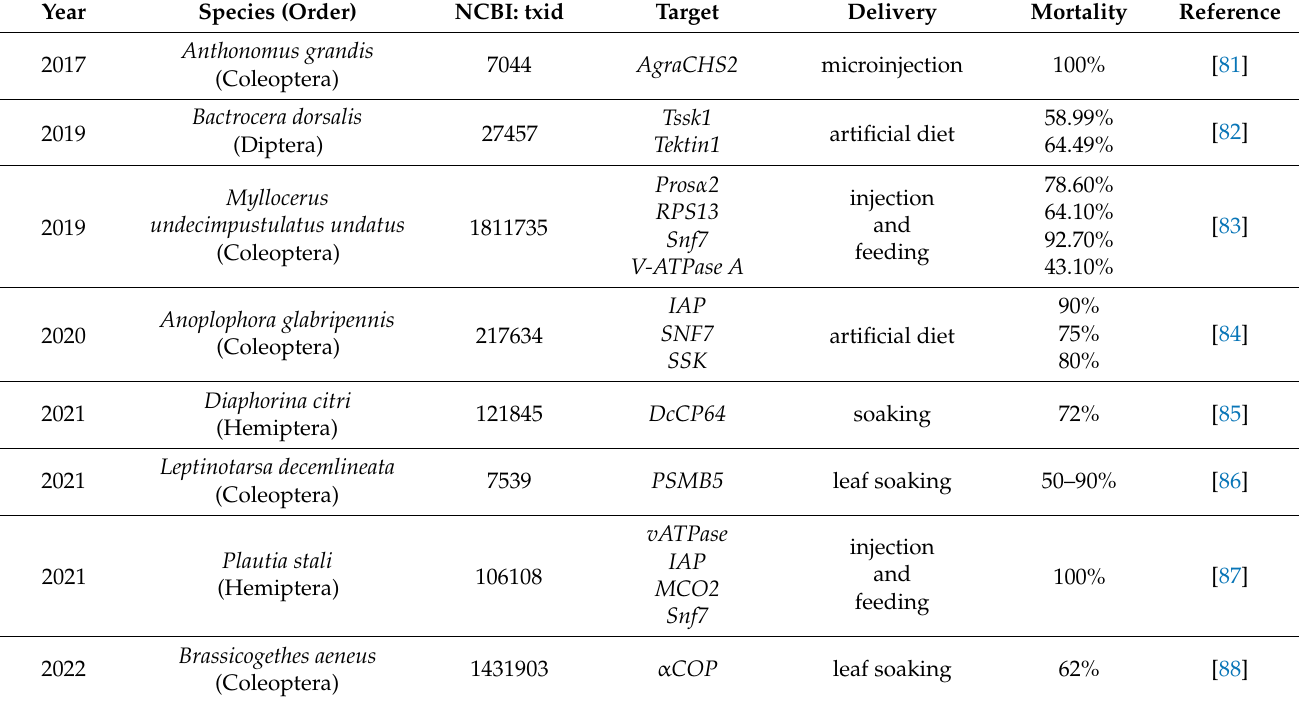
Table 1. dsRNA-validated genes for insect silencing by non-transformative